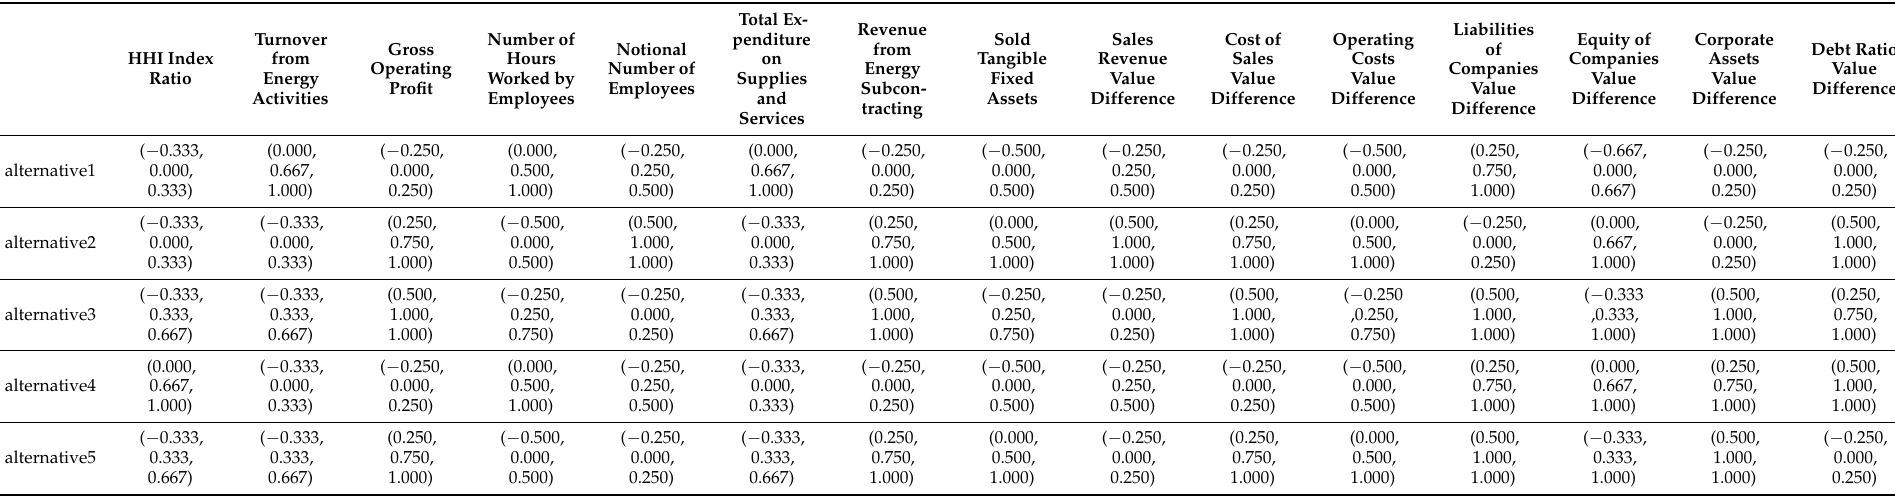
Table 5. The normalized decision